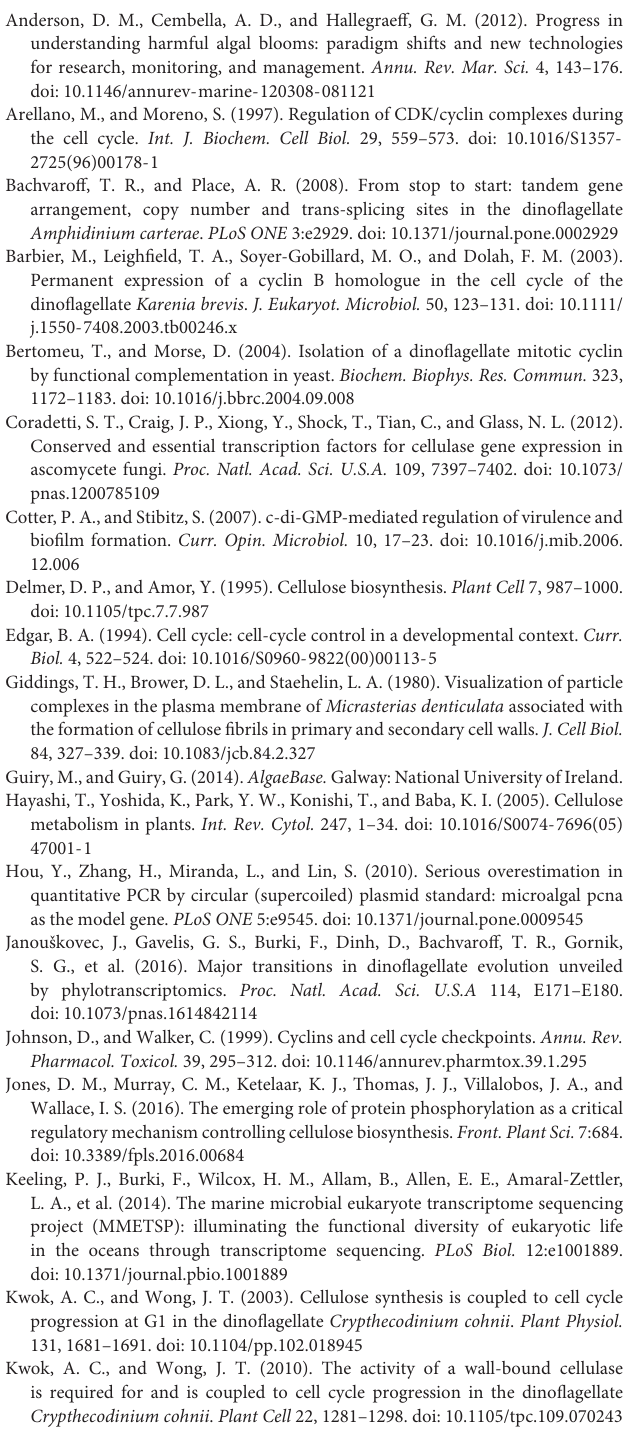
FIGURE S3 | Copy number of gene cellulase (A) , cellulose synthase (B) and G1/S cyclin (C) in P. donghaiense genome were estimated using qPCR. Standard curve (open circle and the line) was constructed using decadal dilution series of respective cDNA, from 10 7 to 10 3 copies, each in triplicate. Three different